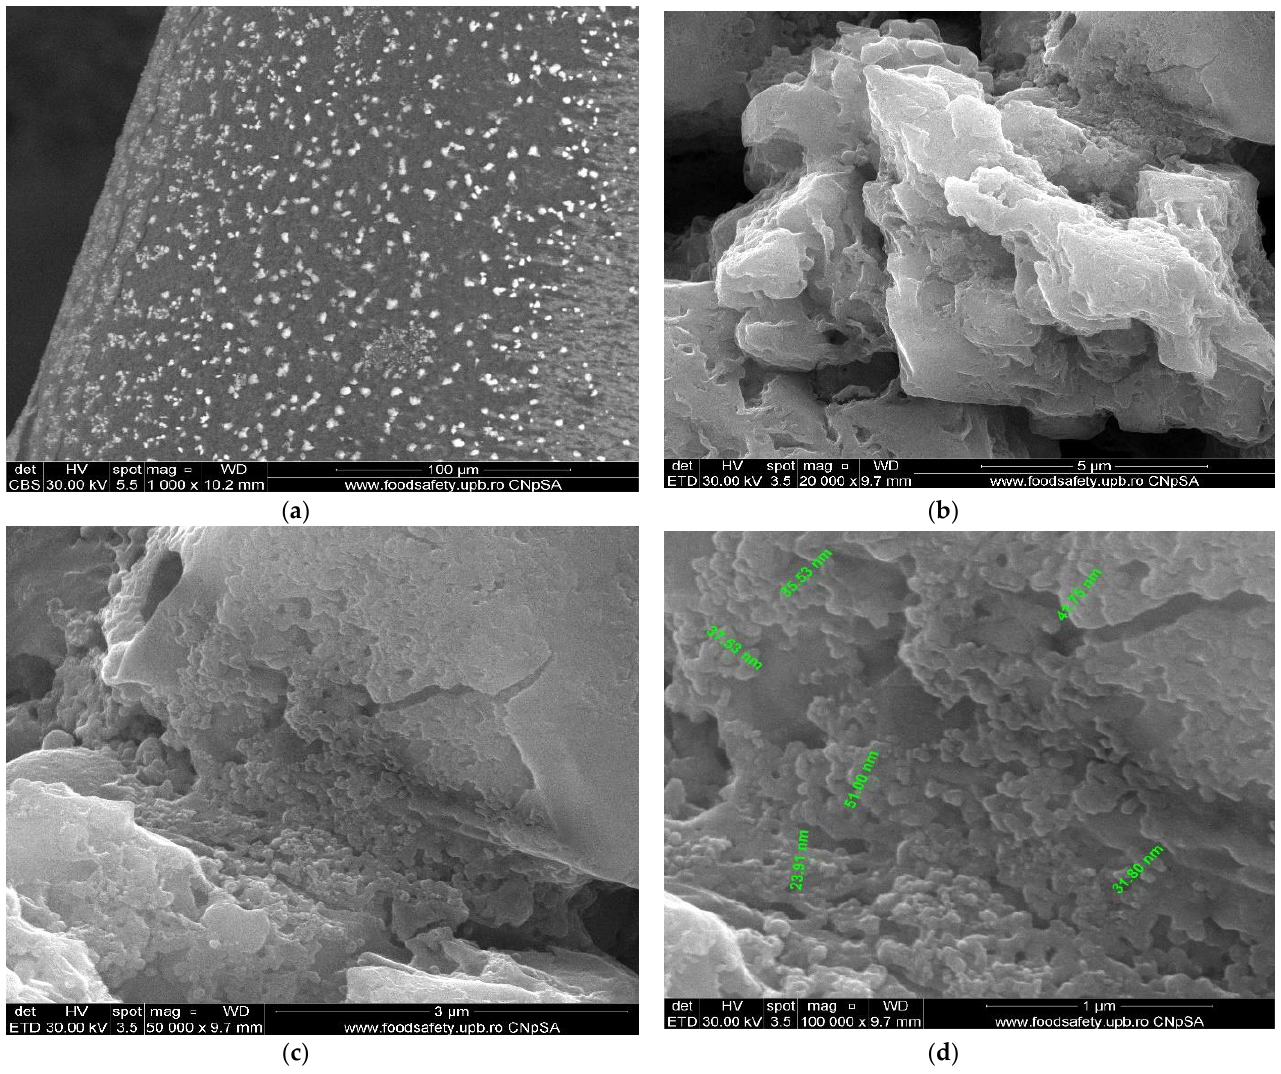
Figure 10. The scanning electron microscopy of the osmium – polypropylene membrane (Os – PP): membrane surface ( a , b ); cross section and nanoparticle details ( c , d ).